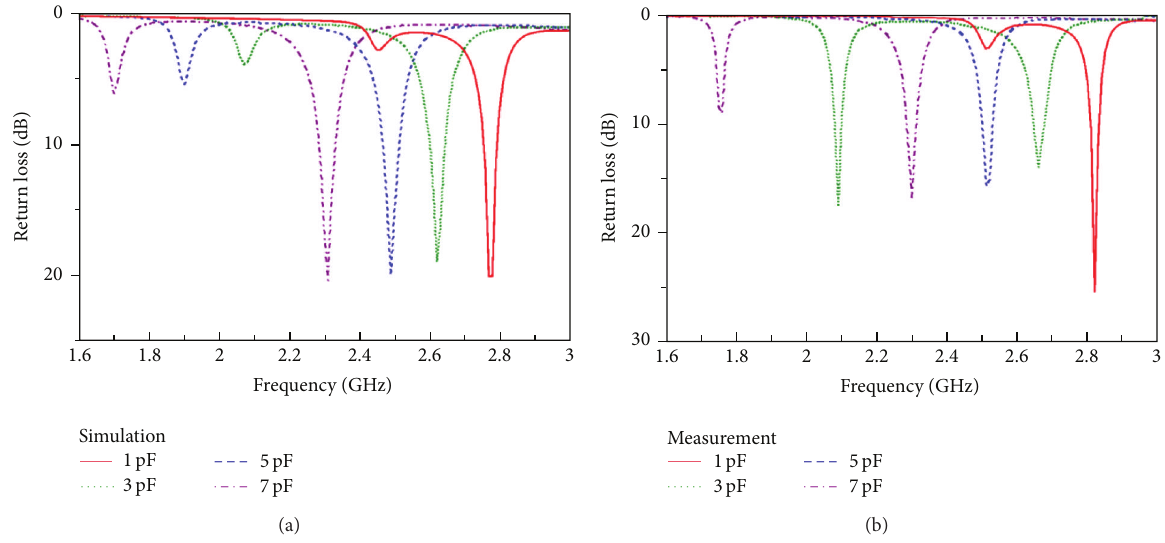
Figure 4: Results of S parameters at different capacitance values. (a) Simulated return losses and (b) measured return losses.